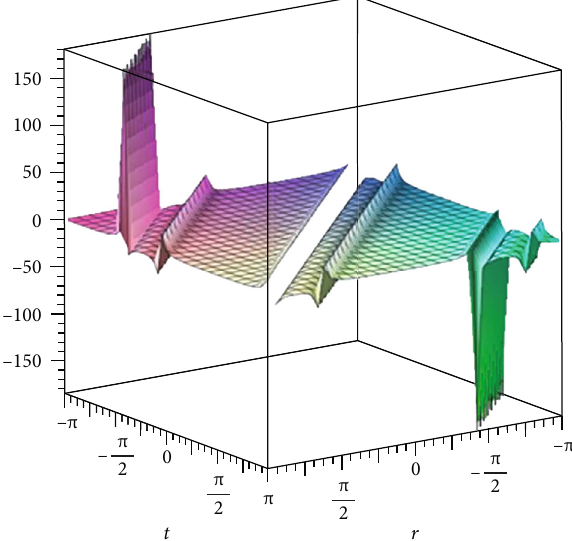
ð (cid:1) r , t Þ , for (cid:1) r , t = − π :: π , s 1